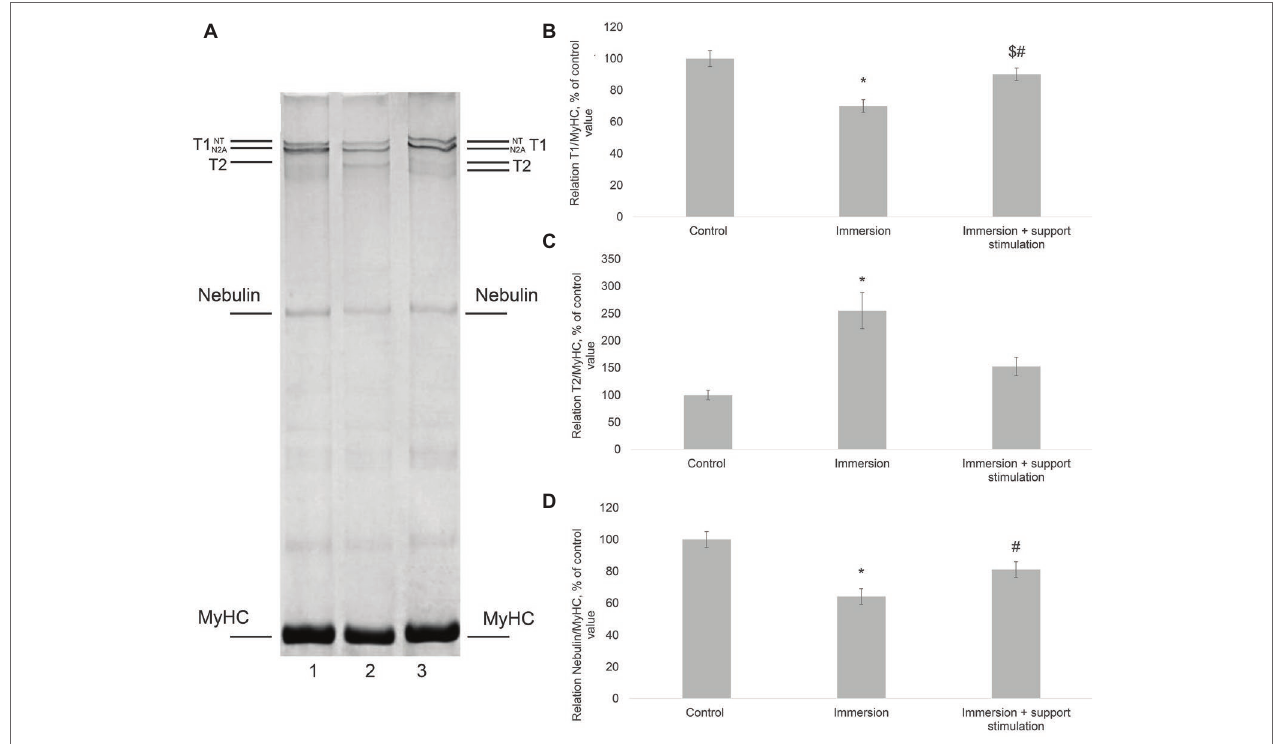
FIGURE 2 | Changes of titin and nebulin content in human soleus muscle. (A) SDS-PAGE analysis of titin and nebulin content in human soleus muscle. 1. Control, 2. Immersion, 3. Immersion + support stimulation. MyHC—myosin heavy chains, T2 is proteolytic fragment of intact titin-1 (T1). N2A and NT are isoforms of T1. (B) , (C) , and (D) Densitometric quantification plots of the titin T1, titin T2, and nebulin, respectively (Shenkman et al., 2004). With kind permission from NAUKA Publishing House (Official Publishers of BIOFIZIKA